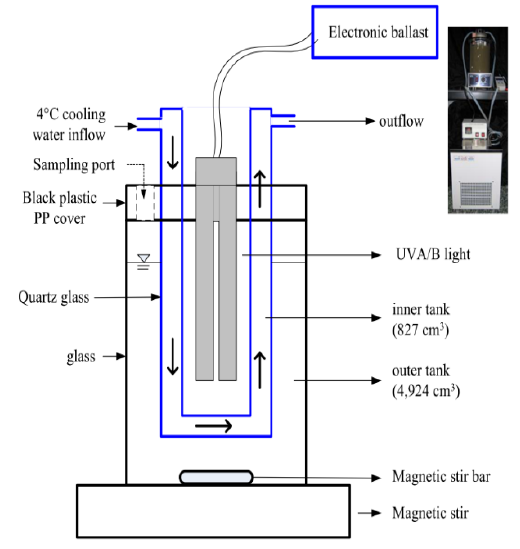
Figure 1. The soil slurry reactor (SSR) used in this study.